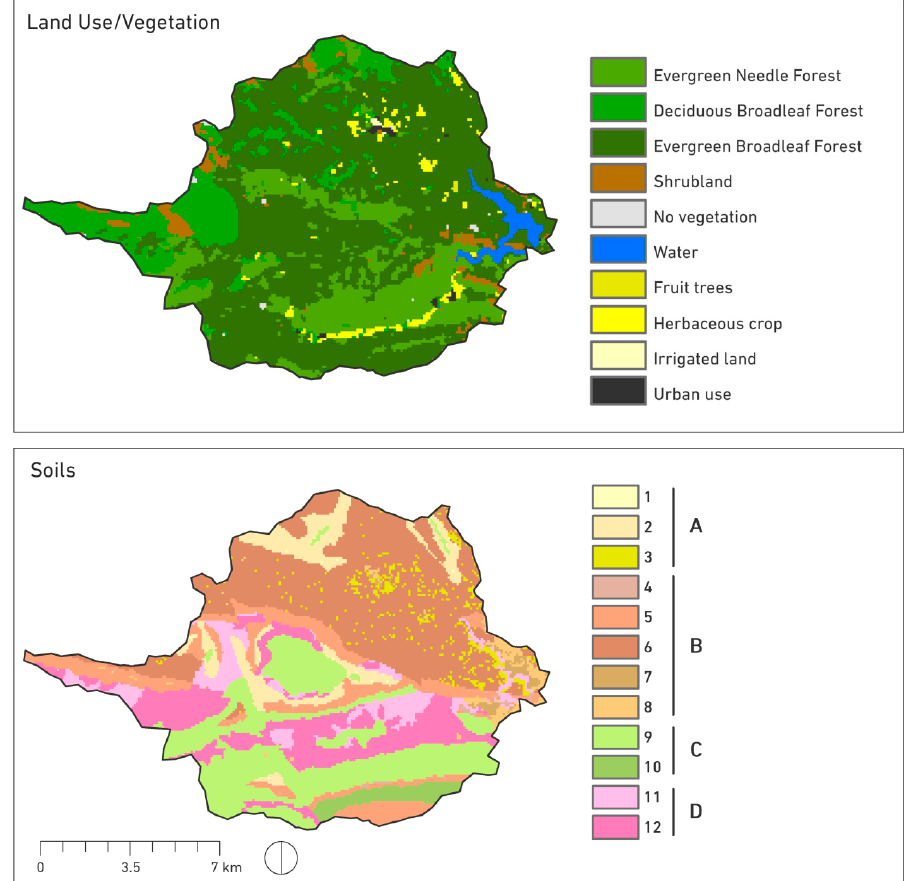
Figure 2. Upper : Actual land-use scenario. Lower : Soils map: (A) Slow infiltration rates with a layer that impedes the downward movement (high runoff potential). (B) Moderate infiltration rates, moderately deep to deep, moderately well to well drained and a moderate rate of water transmission. (C) High infiltration rates, deep and well to excessively drained and a high rate of water transmission (low runoff potential). (D) Very slow infiltration rates, soils with a clay, shallow soils over nearly impervious materials.